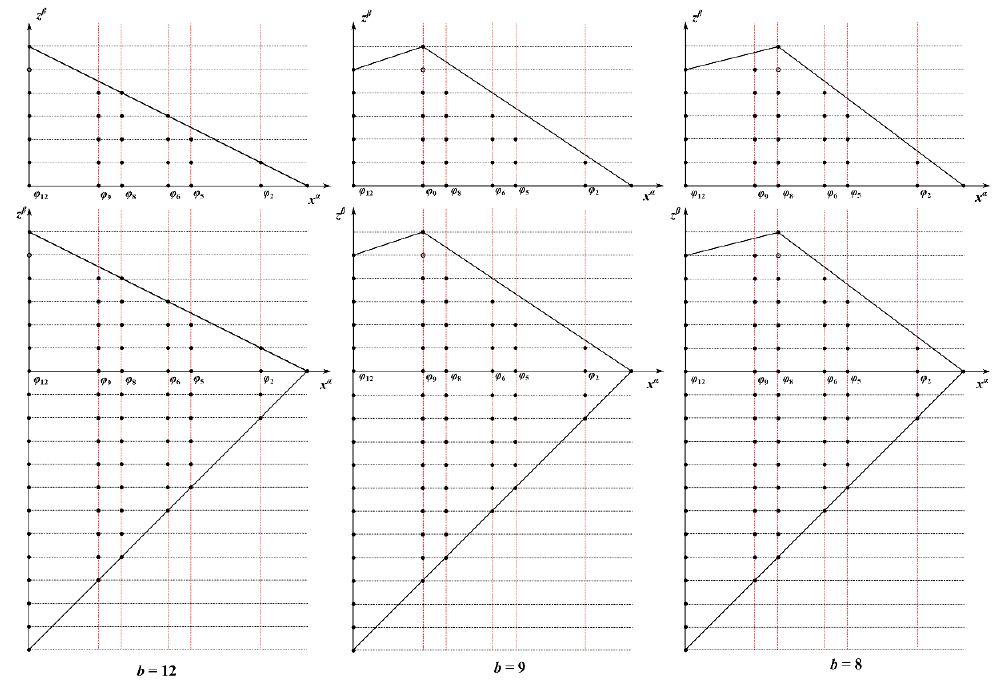
Figure 3 . A collection of Newton polygons for examples of SCFT with g = E 6 . Each black dot represents a monomial in SW curve in the three fold form. The white dots mean that the monomials are omitted. The upper left diagram gives b = 12, k = 6 theory, while the upper middle diagram gives b = 9, k = 6 theory and the upper right gives b = 8, k = 6 theory. The three lower diagrams represent the same irregular puncture, but with an additional regular puncture (e.g. maximal) at south